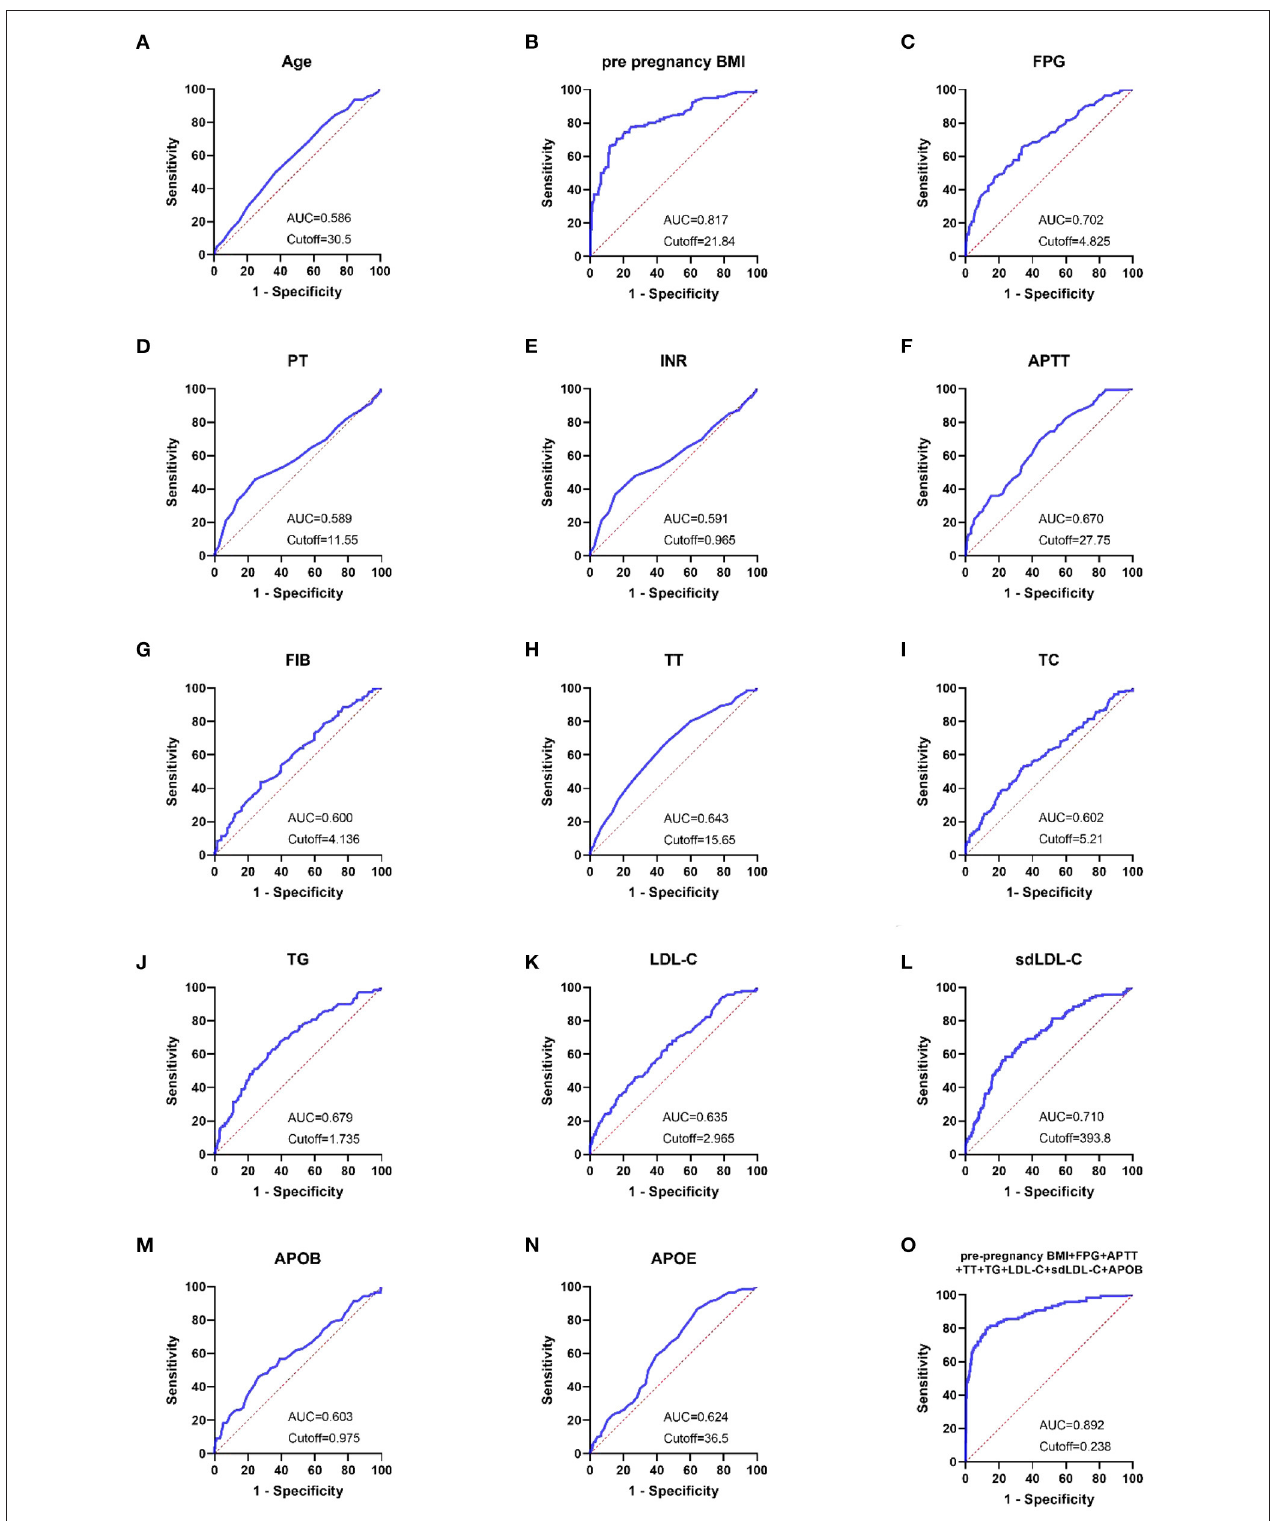
FIGURE 3 | (A–O) ROC curves showed the diagnostic value of laboratory-related indicators for pregnant women with GDM.